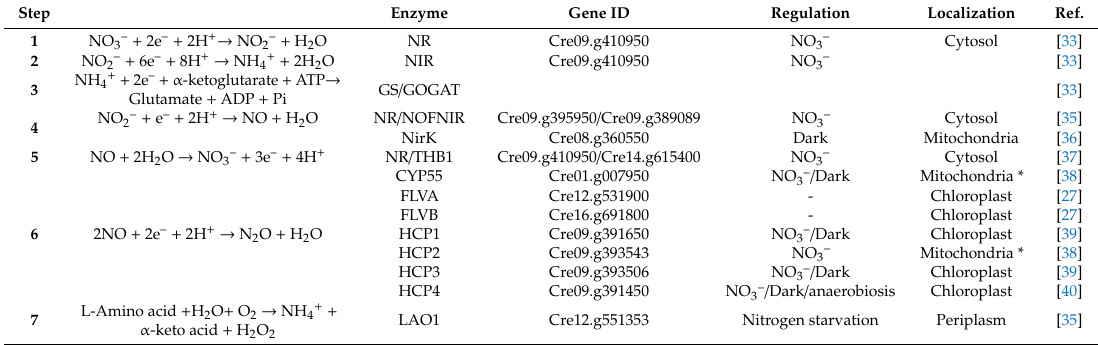
Table 1. Enzymes for nitrogen-transformation reactions in Chlamydomonas